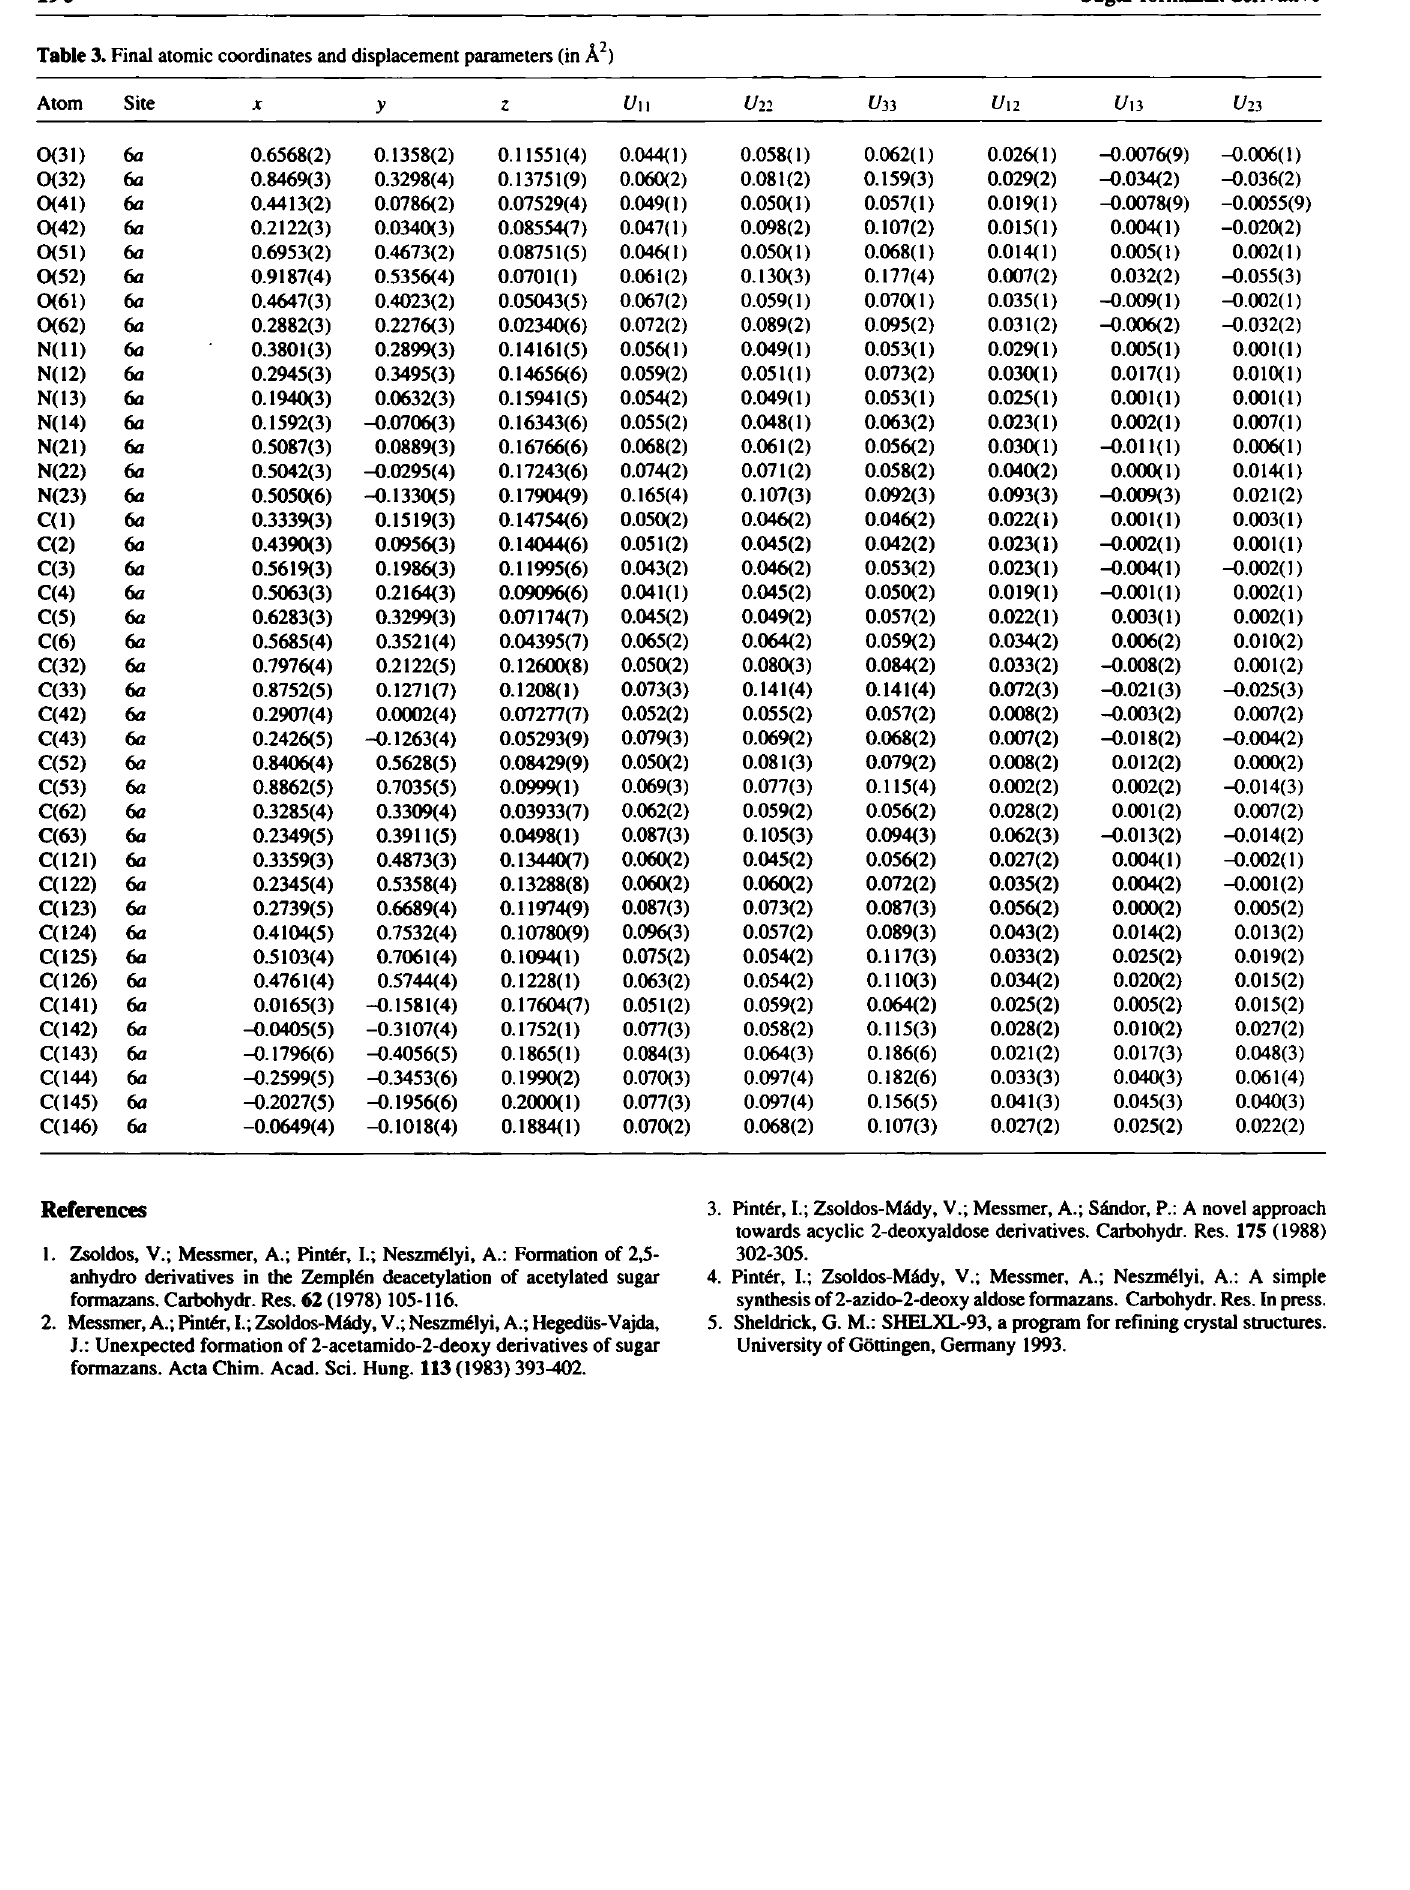
Table 3. Final atomic coordinates and displacement parameters (in Â 2